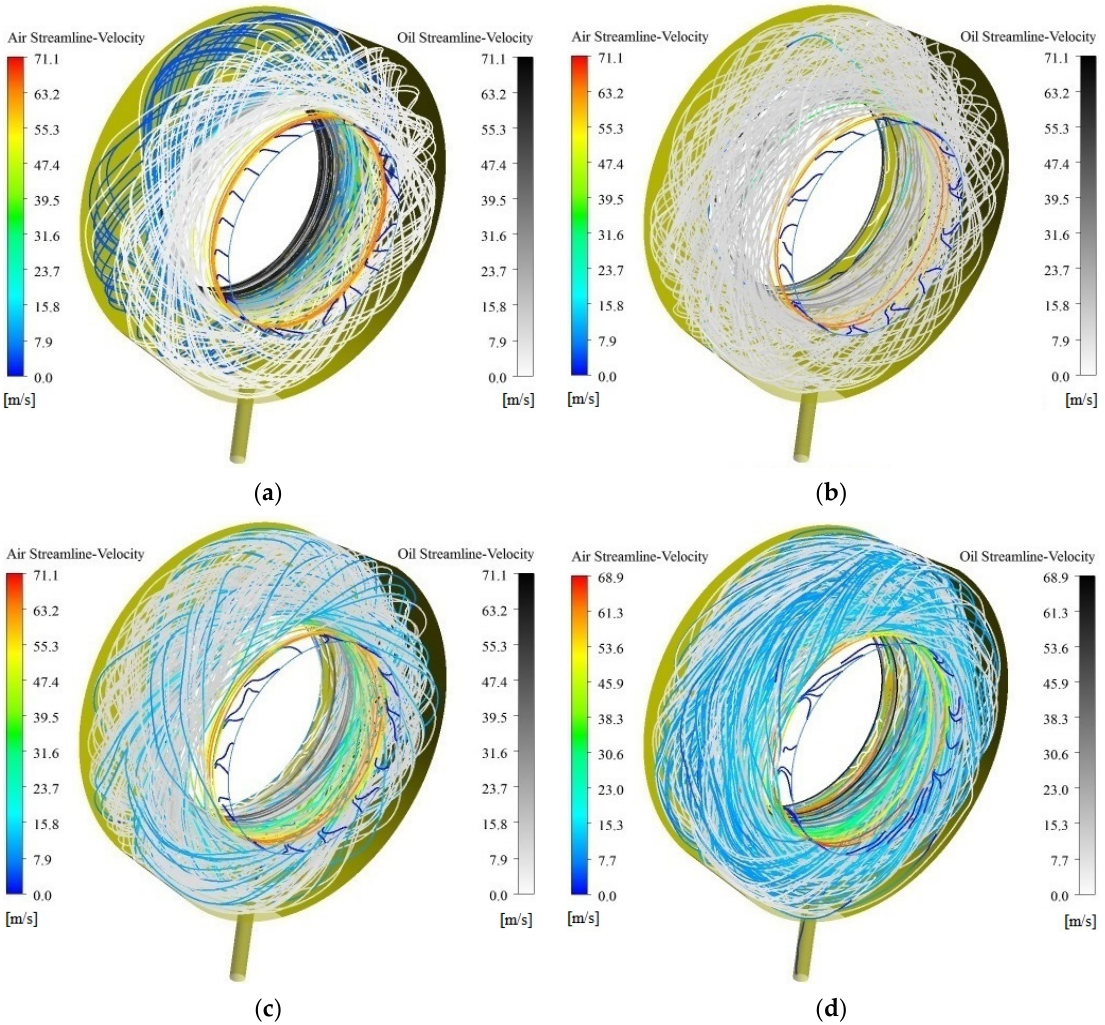
Figure 9. The oil/gas streamlines of the rotational speed driving mode at 10,000 rpm: ( a ) t = 0.056 s; ( b ) t = 0.198 s;( c ) t = 0.213 s; ( d ) t = 0.303 s.